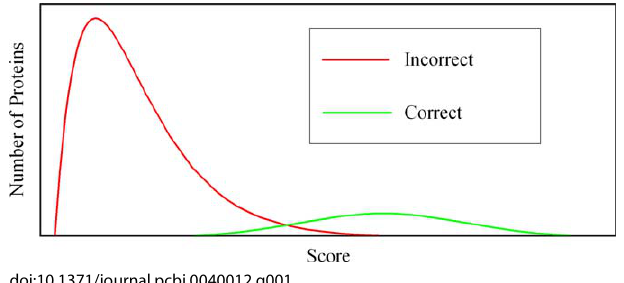
Figure 1. Score Distributions for Correct (Green) and Incorrect (Red) Protein Identifications Using a Scoring Scheme Note that there is no score threshold including all correct identifications while simultaneously excluding all false